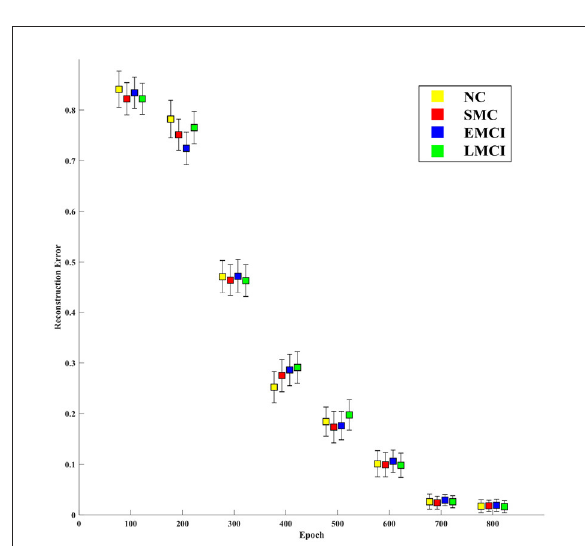
FIGURE13 Mean absolute error between the empirical and generated time series over the training